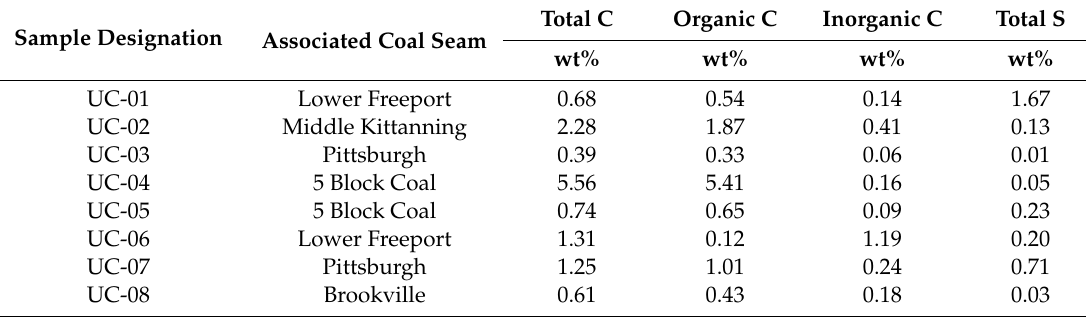
Table 2. Carbon and Sulfur Geochemistry of the Appalachian Basin underclays.